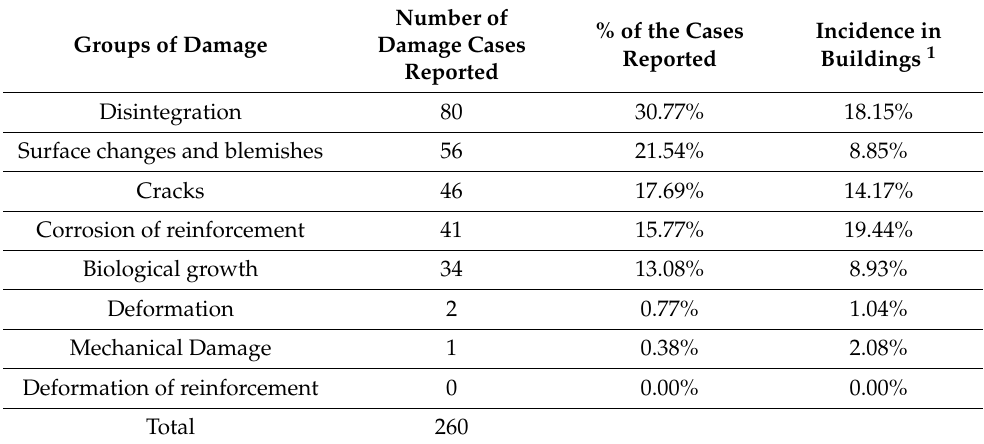
Table 2. Types of damage found in the buildings investigated, percentage, and incidence.